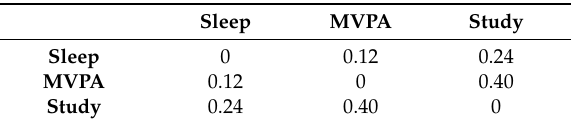
Table 3. Compositional variation matrix of time spent in sleep, MVPA, and study: pairwise log-ratio variances.